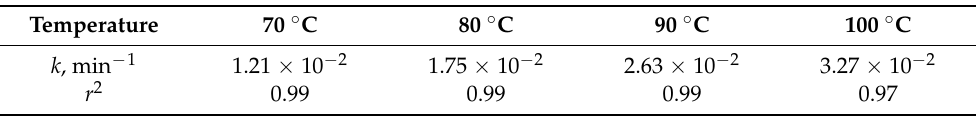
Figure 9. Concentration ratio of triolein versus the reaction time at different reaction temperatures and at a triolein flow rate of 6 mL/min and 5 wt% CaO. Table 2. First-order rate constants for triolein transesterification with methanol on CaO. (Triolein flow rate of 6 mL/min and 5 wt% CaO.)